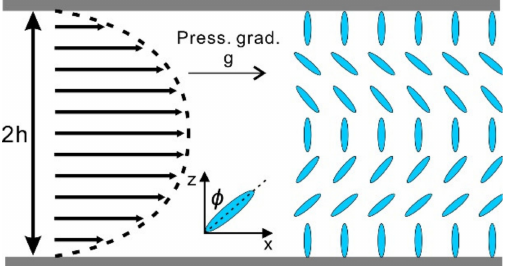
Figure 2. Schematics and the mathematical description of a nematic liquid crystal in the Poiseuille